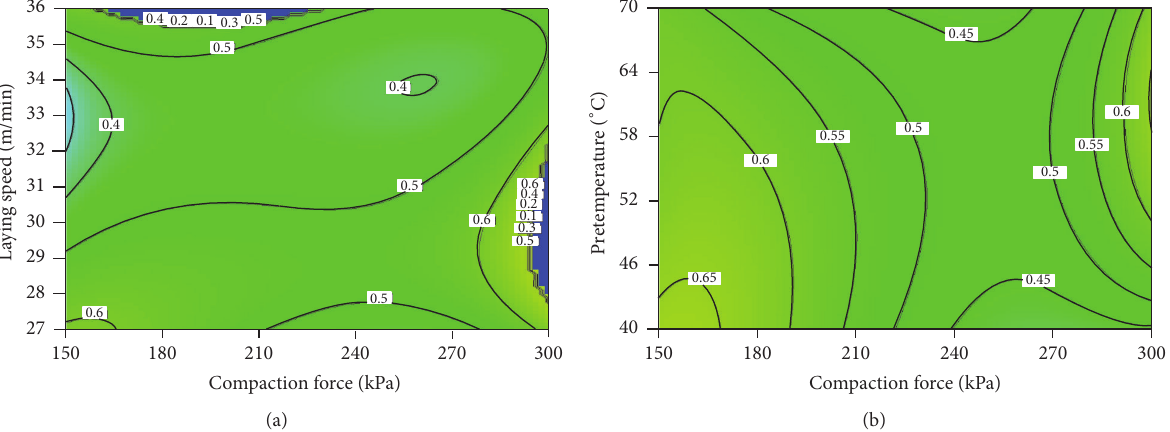
Figure 14: The desirability analytical results: (a) compaction force and laying speed; (b) pretemperature and compaction